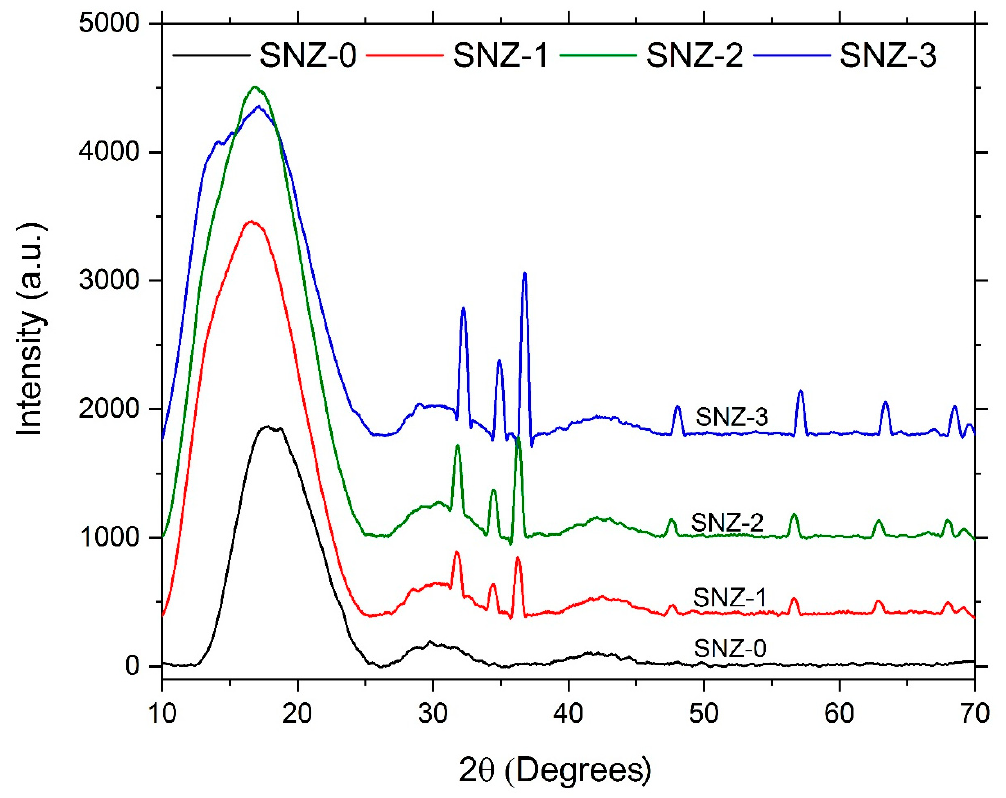
Figure 3. XRD patterns of the SiO 2 / ZnO-incorporated composite epoxy coatings. The composition details of these formulations are provided in Table 1 .